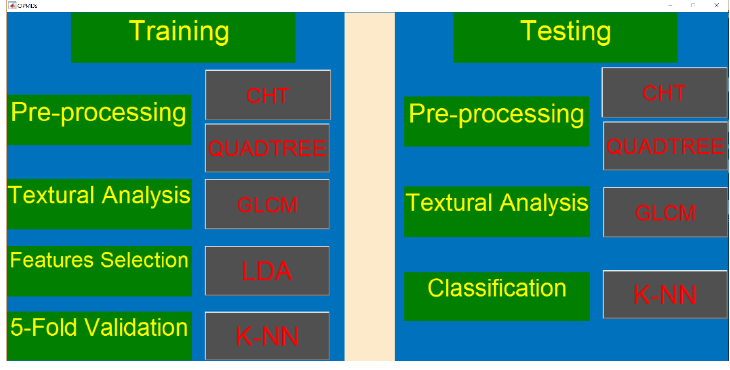
Figure 23. GUI for